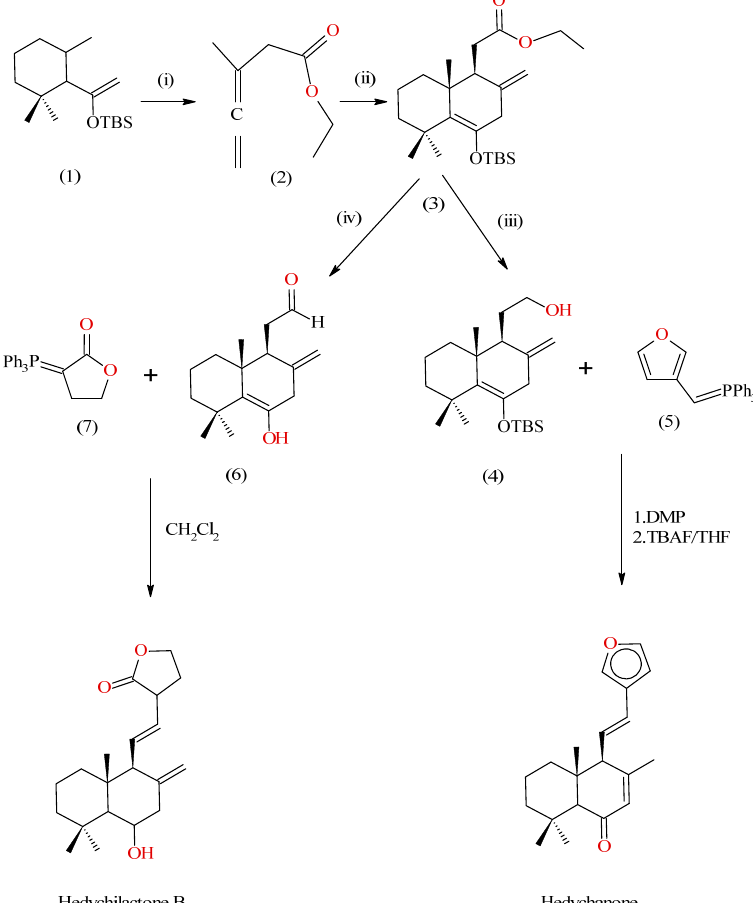
Figure 6. Synthesis of Hedychenone and Hedychilactone B, where (1). hindered diene; (2). allene car- boxylate; (3). [4+2] cycloadduct; (4). corresponding alcohol of cycloadduct prepared by DIBAL reduc- tion; (5). 3-Furyl ylide; (6). corresponding aldehyde of cycloadduct; (7). tri-Phenylphosphoranylidene lactone. (i), (ii), and (iii) are synthetic roots for the preparation of